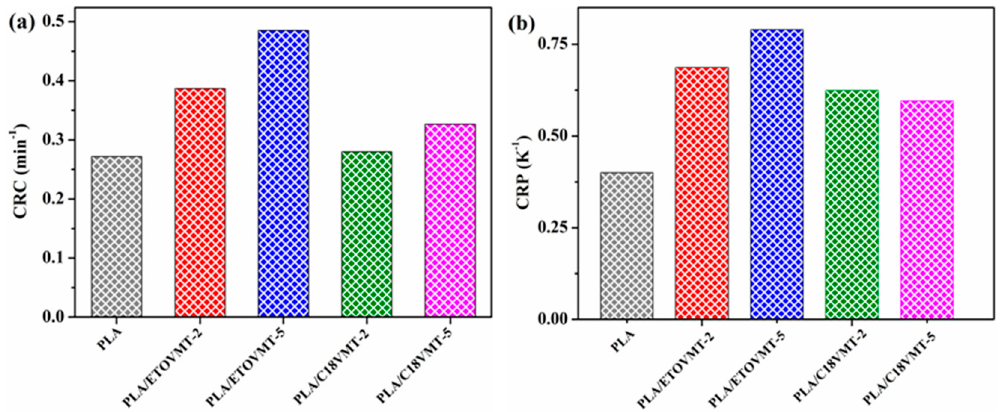
Figure 9. ( a ) Crystallization rate coefficient (CRC) and ( b ) crystallization rate parameter (CRP) values of PLA and PLA/VMT nanocomposites.